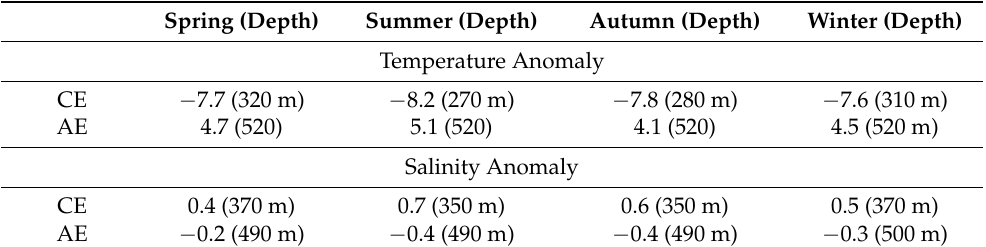
Table 3. Statistics on the extreme value of ARMOR 3D temperature and salinity anomalies in different seasons.